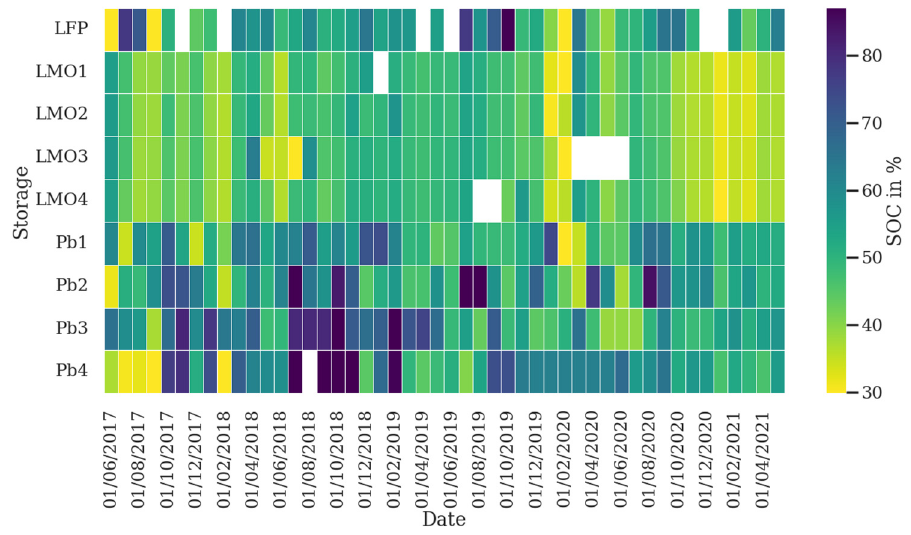
Figure 8. Monthly average SOC of the battery units.